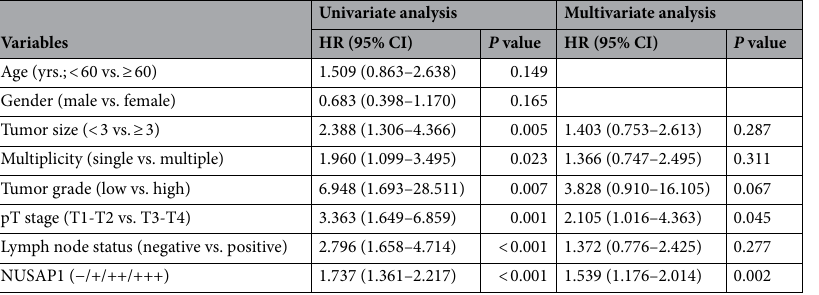
Table 7. Univariate Cox and multifactorial analysis for factors influencing 5-year-overall survival after surgery for BUC.